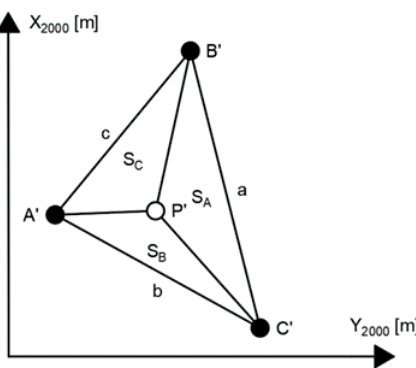
Figure 5. Illustration of point height determination in a Triangulated Irregular Networks (TIN) model.